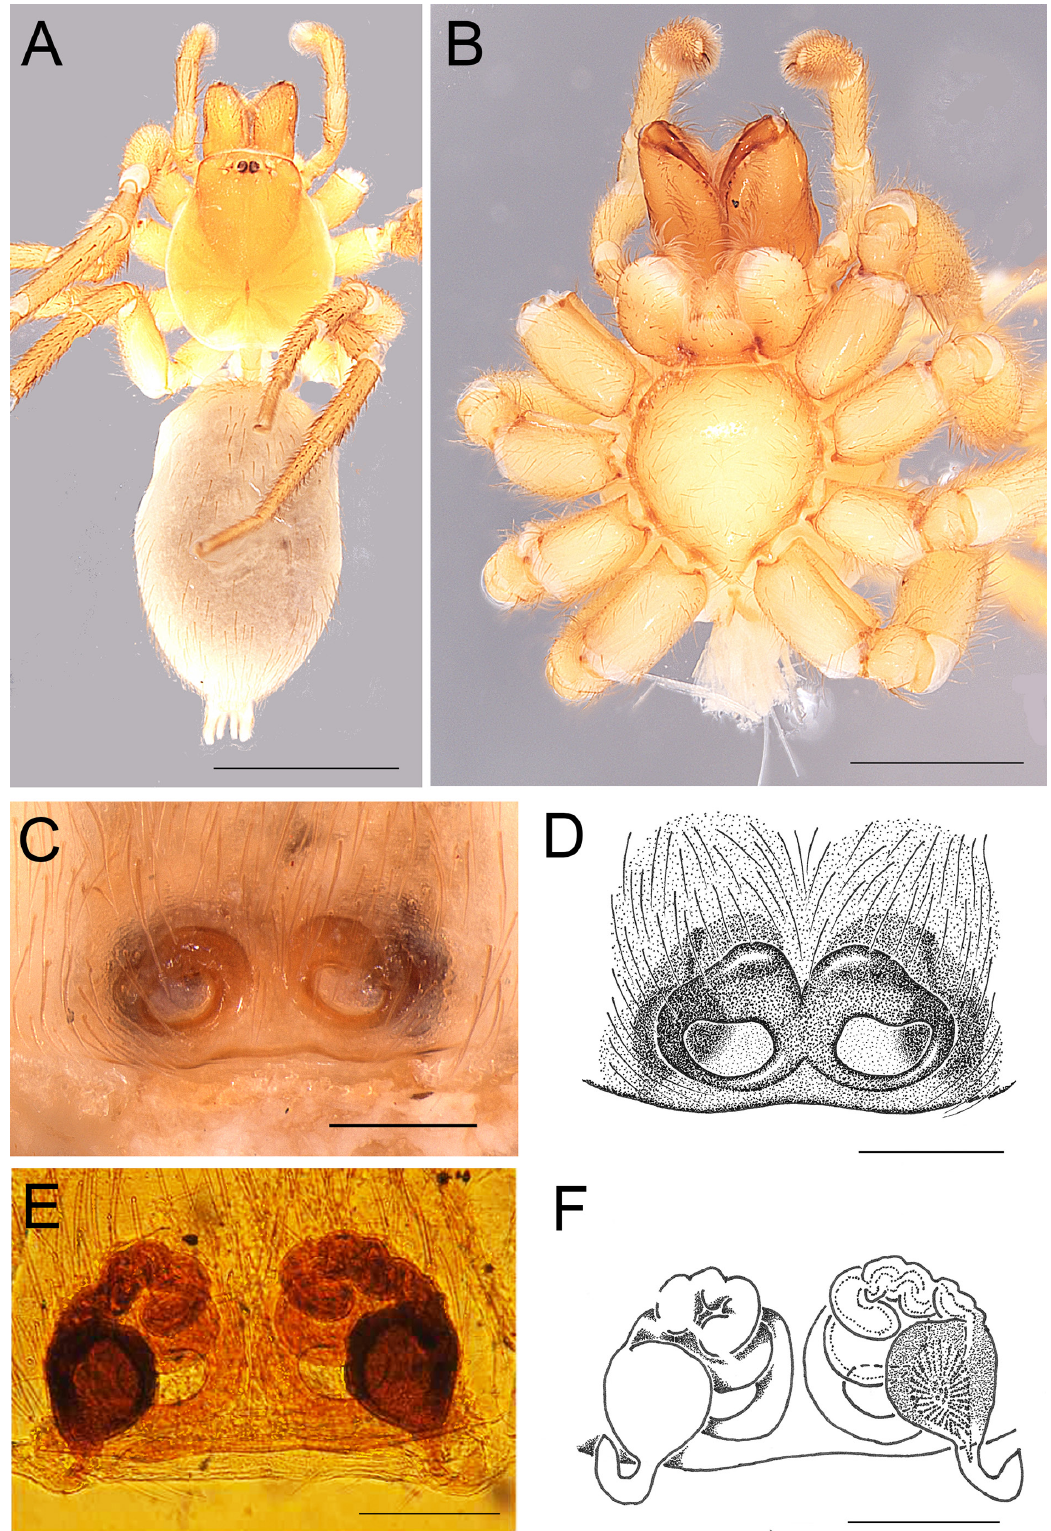
Fig. 30. Andromma ophiophagum sp. nov., ♀, holotype (RMCA_ARA_Ara 144686). A . Habitus, dorsal view. B . Cephalothorax, ventral view. C–D . Epigyne, ventral view. E–F . Same cleared, dorsal view. Scale bars: A = 2 mm; B = 1 mm; C–F = 0.2